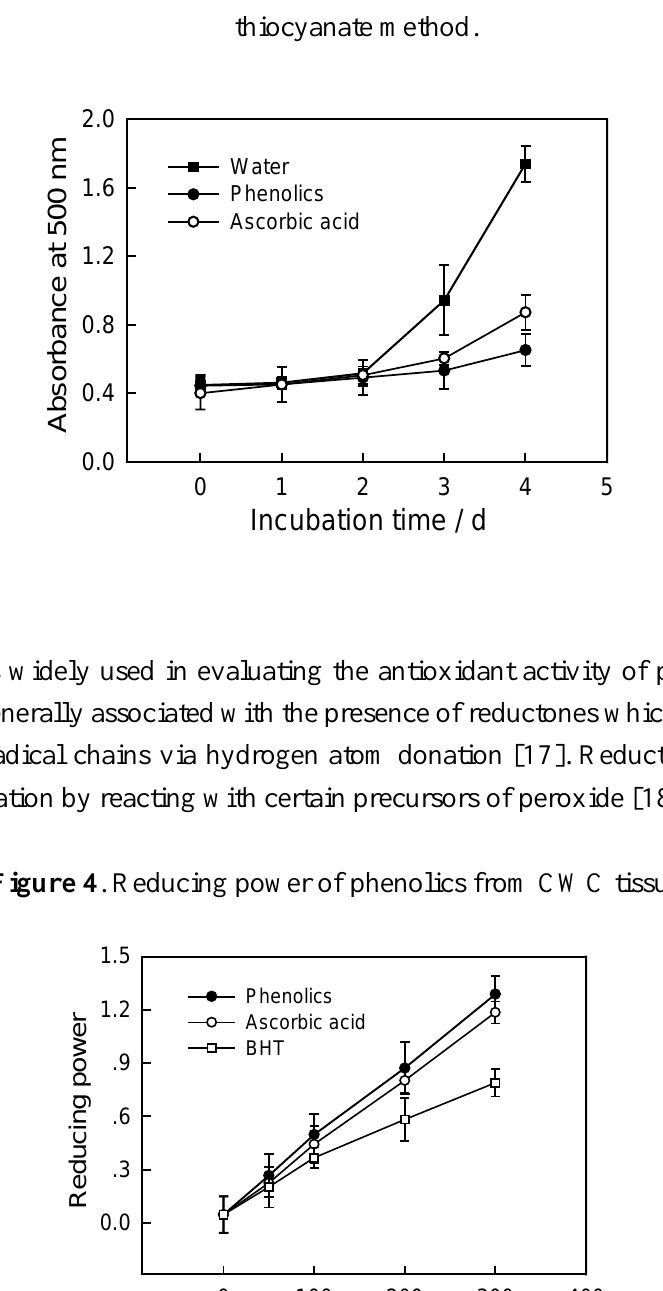
Figure 3. Antioxidant activity of phenolics from CWC tissues, measured by the ferric thiocyanate method.